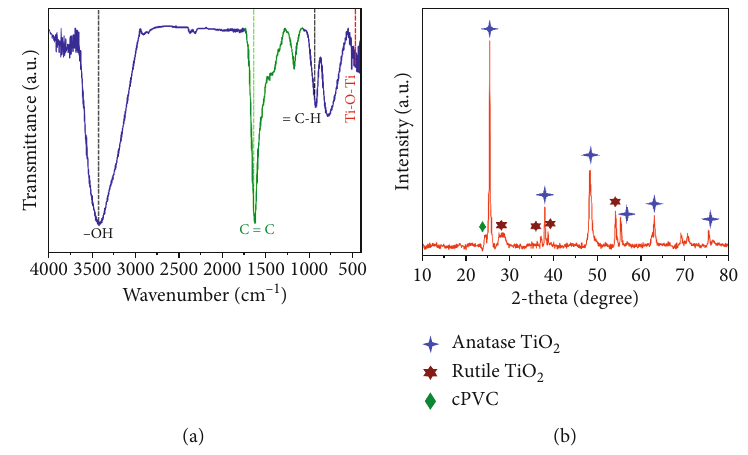
Figure 1: (a) FTIR spectrum and (b) XRD pattern of cPVC/TNT nanocomposite.